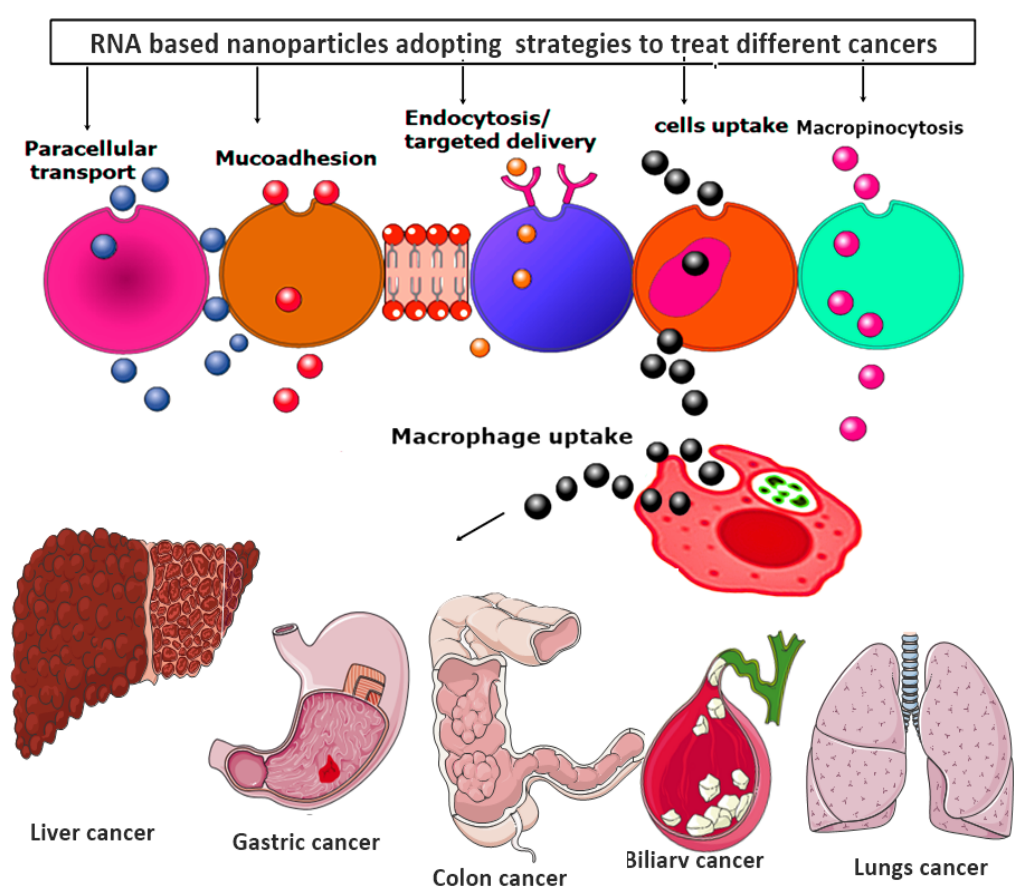
Figure 6. RNA-based nanoparticles various advanced strategies for providing the targeted and efficacious treatment against various metastatic cancers.